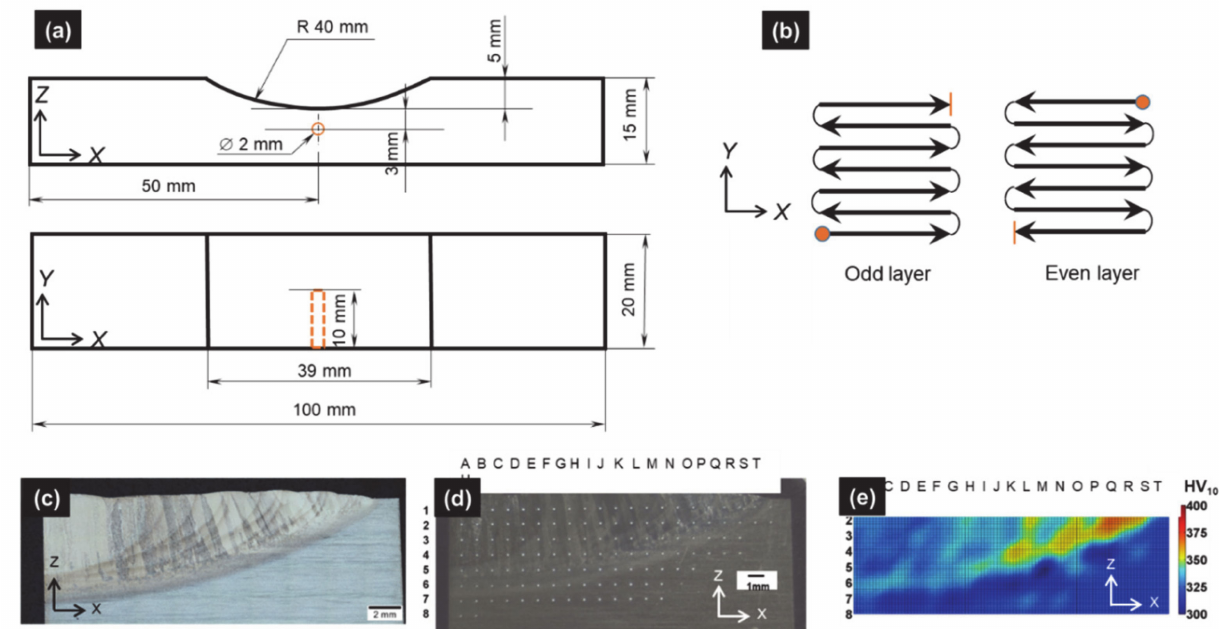
Figure 5. ( a ) Sample geometry and type-k thermocouple location within the substrate; ( b ) path of laser beam for the DTL deposition strategy (7 tracks/layer, and 10 layers); ( c ) view of half deposit in as-built conditions with columnar macrostructure and enhancement of HAZ (dark curved areas) and large nugget in the center (light area); ( d ) indentations grid within the cladded deposit (HV 10); ( e ) Vickers hardness